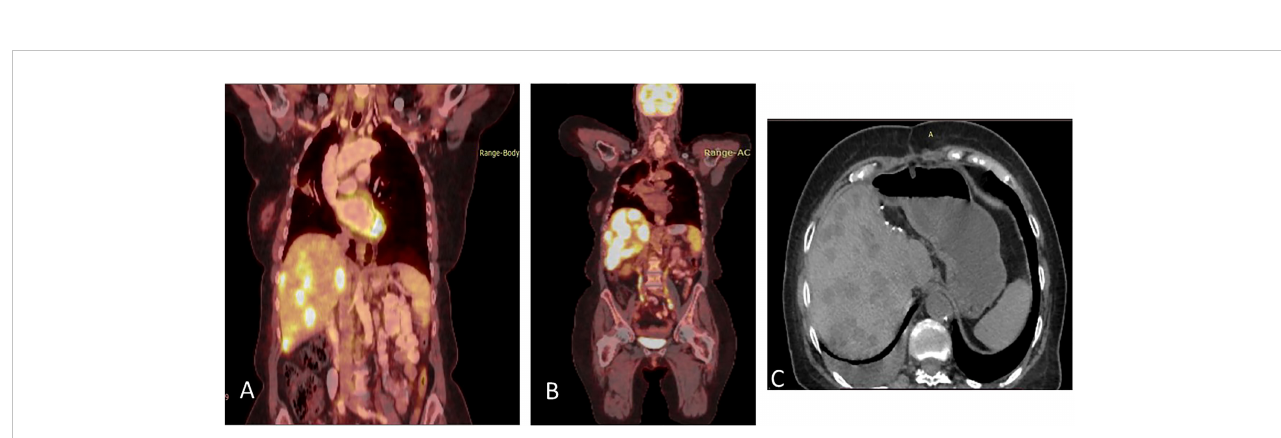
FIGURE 3 (A) Coronal section, superimposed PET-CT scan, December 2020. Four years after the fi rst presentation of stage 3B NSCLC, the right lung shows a signi fi cant reduction in FDG-18 uptake and decreased tumor size, with only a scar, indicating the lung ’ s complete response to treatment. However, status-post left hepatectomy, there is increased FDG-18 uptake in the right lobe of the liver, consistent with multifocal right hepatic metastatic disease. (B) Two months later, February 2021, there is further progression in size, number, and metabolic activity of metastases throughout the right lobe of the liver, indicating more aggressive disease. There remains no evidence of recurrent or residual disease in the lung. (C) Non-contrast, axial CT scan from April 2021 shows interval regression in size and number of liver masses. The white spots are sutures from the surgery to remove the left hepatic lobe (status-post left hepatectomy).